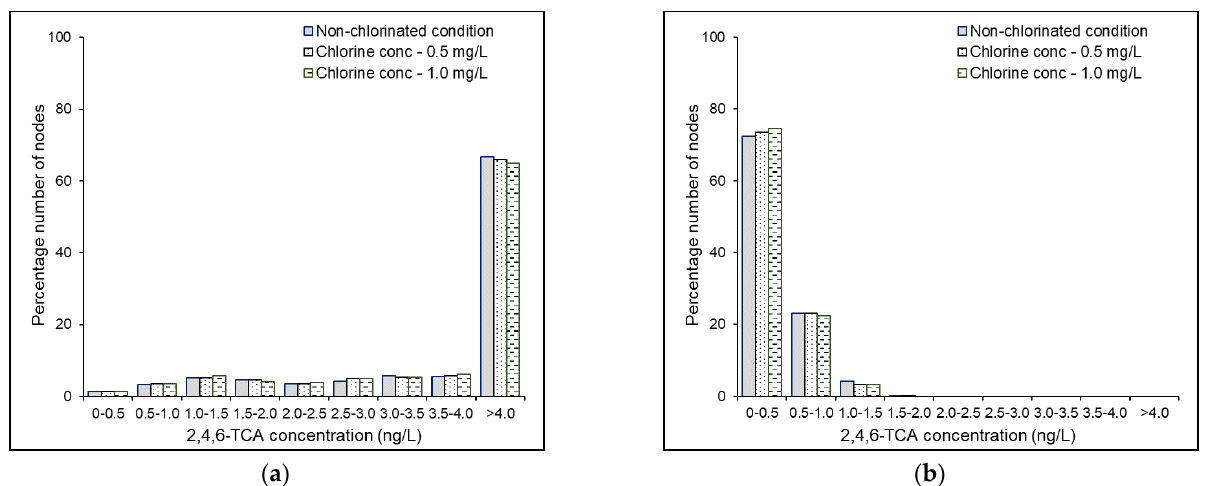
Figure 5. Predicted distribution of 2,4,6-TCA in the KLmod network under T = 25 ◦ C, and P o = ( a ) 0.2 and ( b ) 0.01 mg/L.